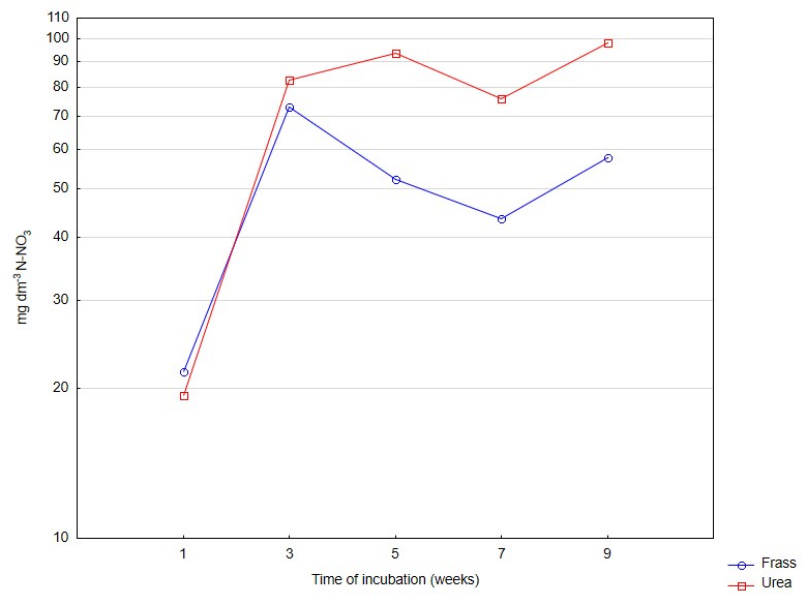
Figure 1. Changes in the content of N ‐ NH 4 in deacidified peat incubated with frass and urea. Differences are presented on a logarithmic scale.